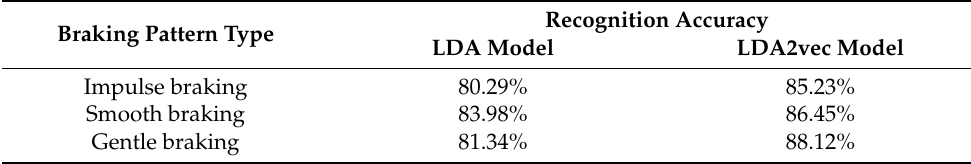
Table 4. Braking pattern recognition accuracy of the LDA and LDA2vec